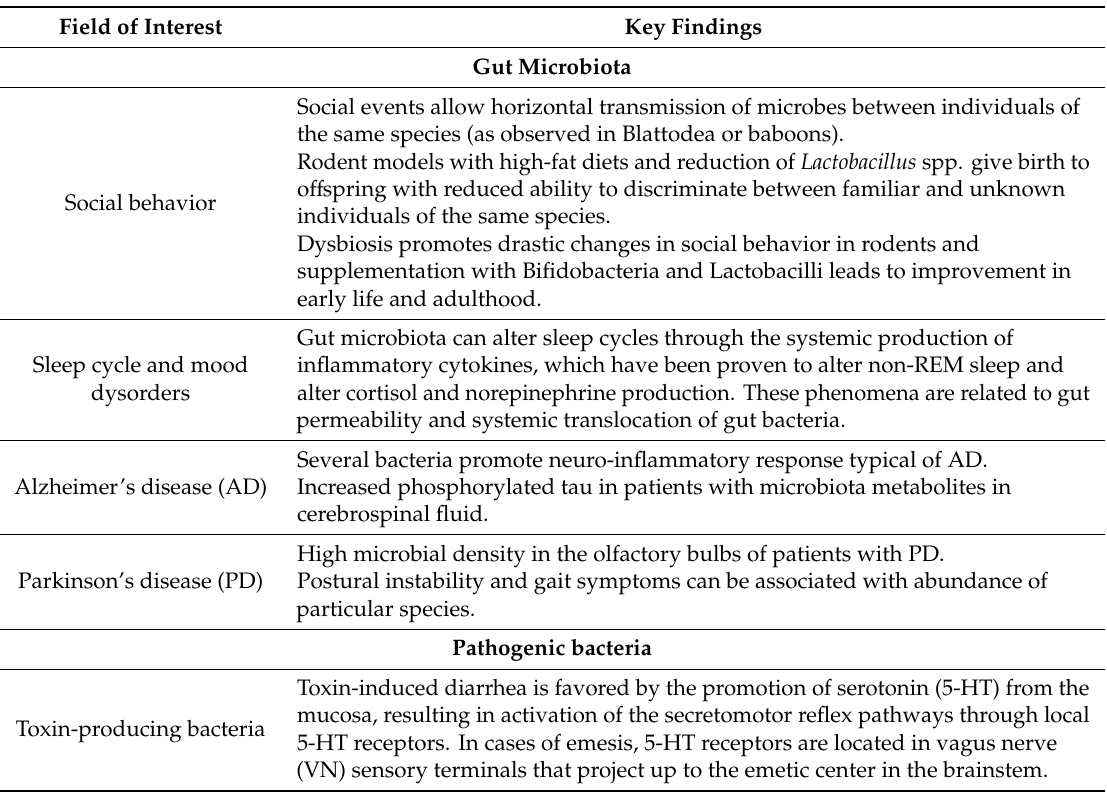
Table 1. Bacteria and the enteric nervous